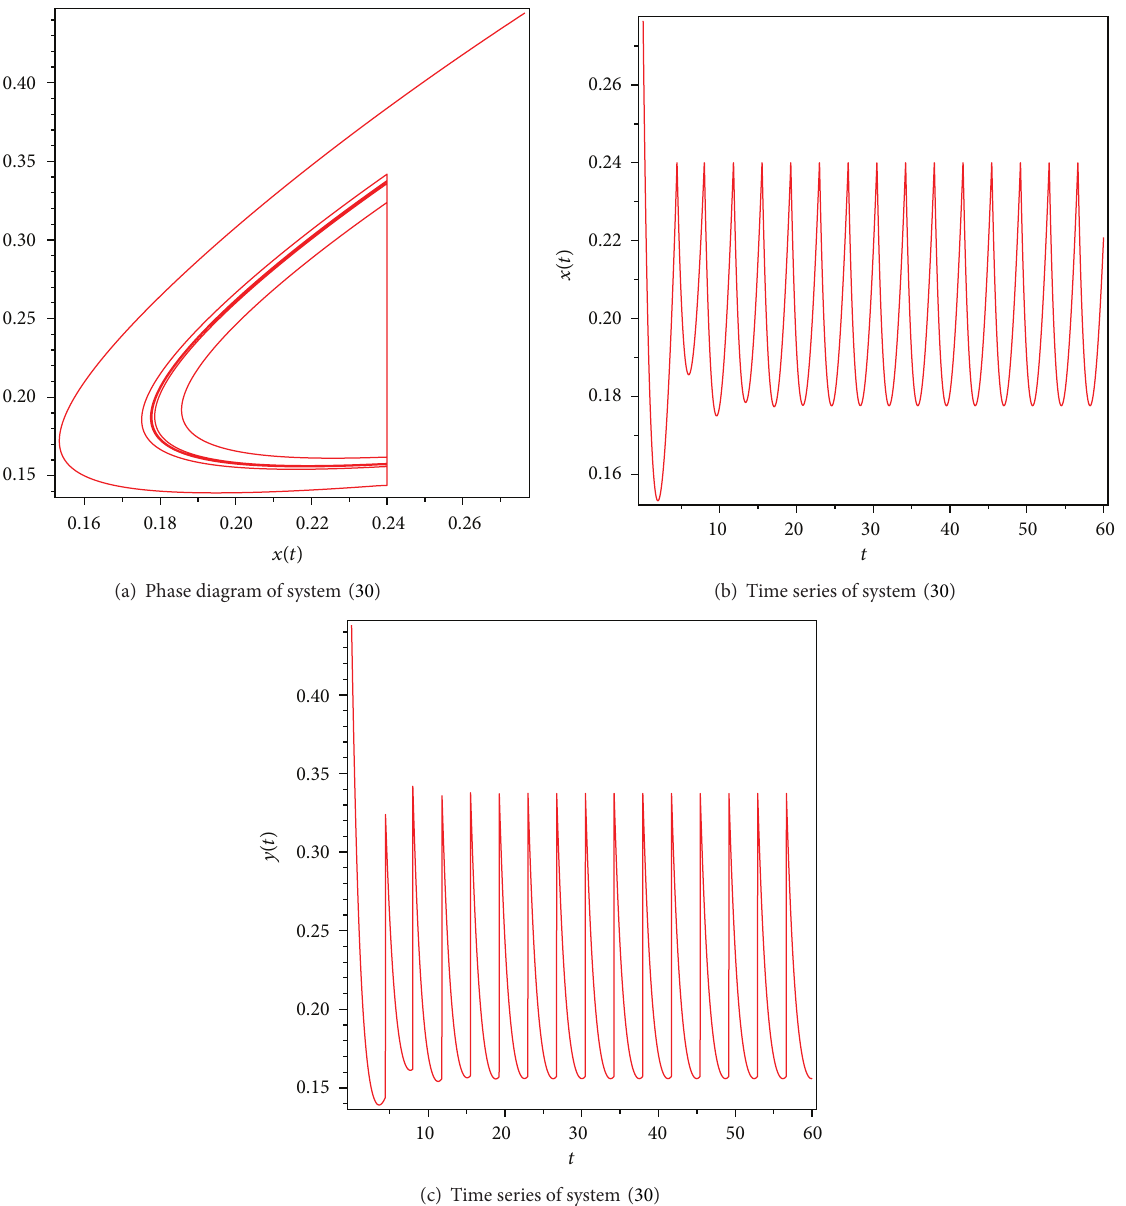
Figure 12: The periodic solution corresponding to Figure